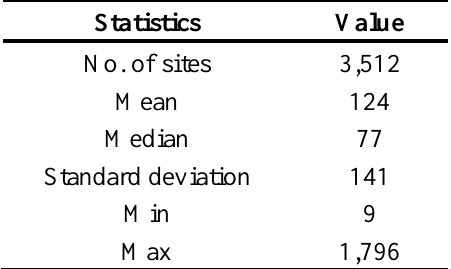
Table 1. Summary statistics of IRC in Lombardy.